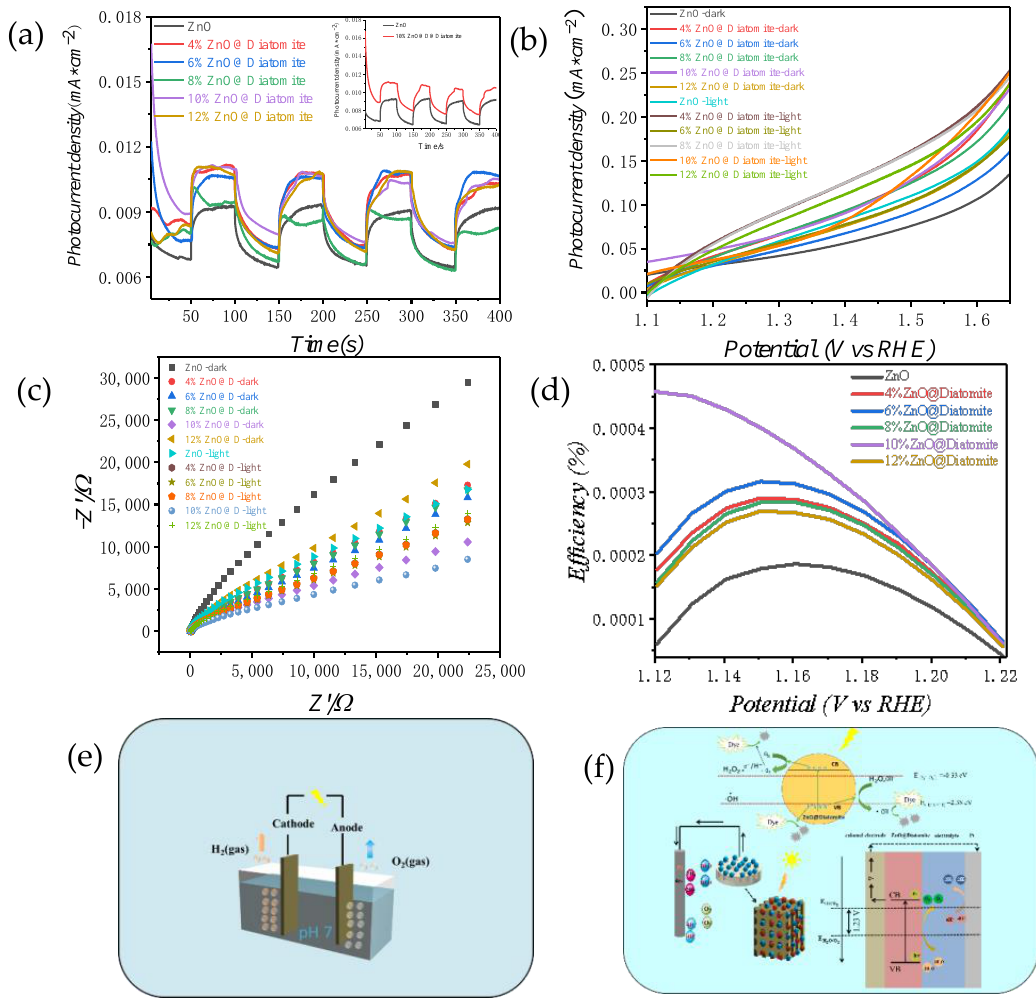
Figure 13. ( a ) Amperometric I–t curves. ( b ) Photocurrent density. ( c ) Nyquist plots of pure ZnO and X%ZnO@diatomite. ( d ) Water splitting efficiency of pure ZnO and X%ZnO@diatomite. ( e , f ) Schematic representation of the possible mechanism of photogenerated charge separation at the interface of X%ZnO@diatomite with the corresponding energy band diagram during PEC water Figure 13. (a) Amperometric I – t curves. (b) Photocurrent density. (c) Nyquist plots of pure